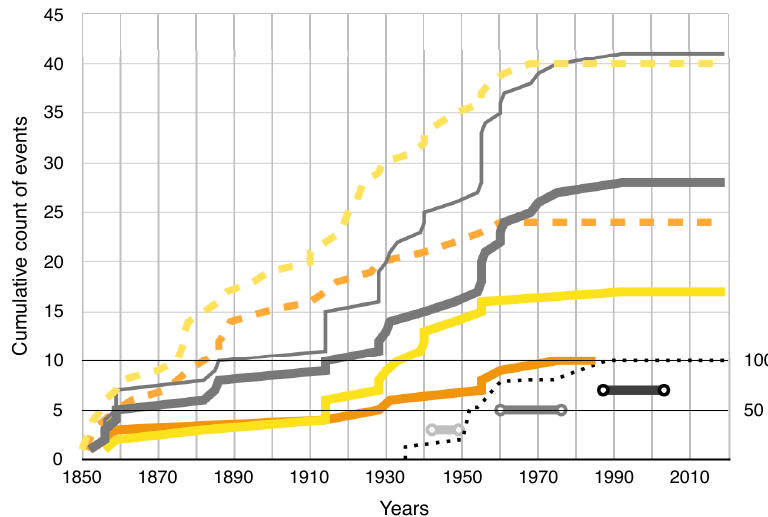
Figure 6. Cumulative counts of riverine flood events reported in the RTM database over the period 1850–2019. In total, over the period, 41 events have been reported for the 5 RTM riverine sites (continuous thin grey curve). Taking into account the multiple-site events—i.e., events concerning several sites of either the Isère or the Drac Rivers—these 41 events reduce to 28 events (continuous bold grey curve), among which 18 events concern the Isère River (yellow bold curve) and 10 events concern the Drac River (orange bold curve). These last two curves are compared with the series of 51 events of the “Historisque” research dataset for the Isère (dashed yellow curve) and Drac Rivers (dashed orange curve). The represented slopes (dotted grey lines) are the ratios between the total counts and the duration of the considered period (Poisson hypothesis). The time evolution of the storage capacity of the reservoirs built on the Isère an Drac Rivers (dotted black curve graduated in percent of the final capacity reached in the 1990’s—right hand y-axis) as well as the temporality of the main post-World-War-II protection programs (three dotted grey bars representing successively the so-called Schneider Project, the update of Grenoble dikes, and the rising of the Isère Left Bank dike) are also sketched on the graph (arbitrary